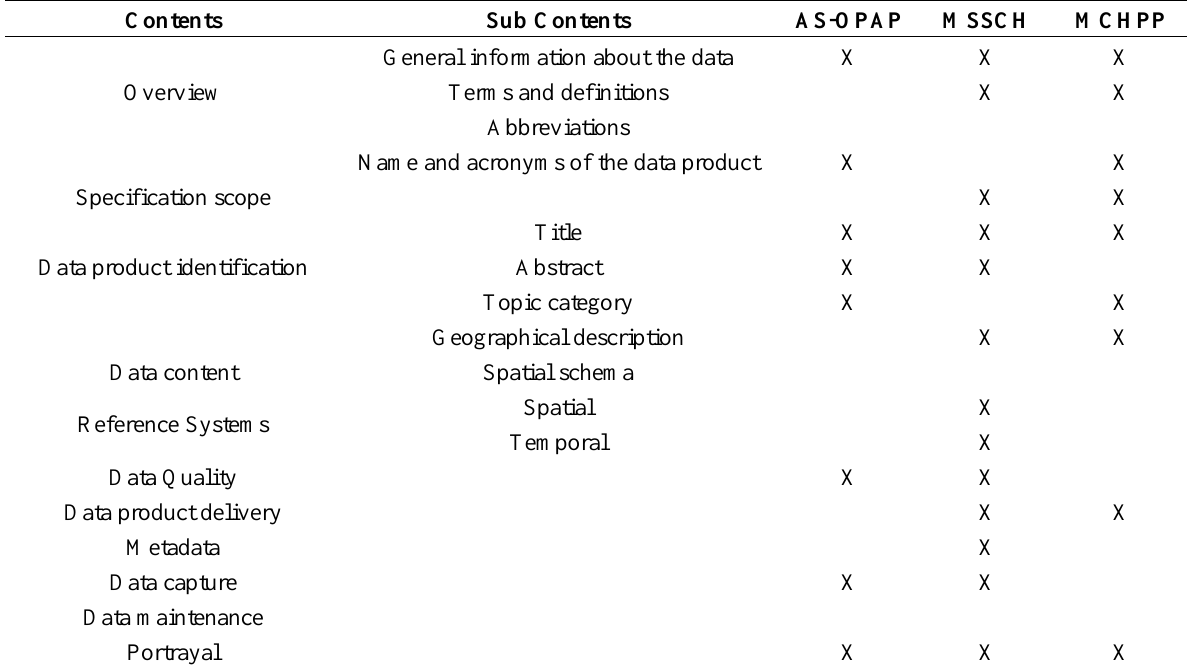
Table 1. Completeness analysis of Advice and Suggestions for the furtherance of Optimum Practice in Architectural Photogrammetry surveys (AS-OPAP), Metric Survey